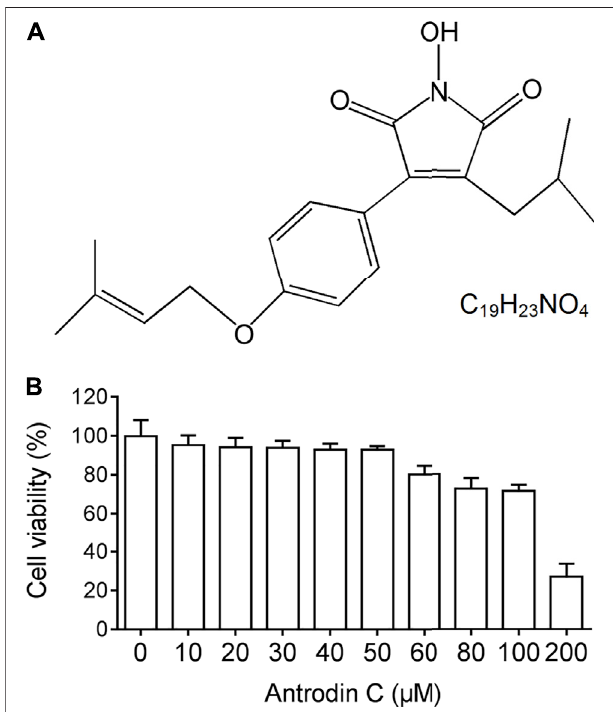
FIGURE 1 | The chemical structure and cell viability of CSFC-8B cells treated with Antrodin C (A) The chemical structure of Antrodin C. (B) Effect of Antrodin C on cell viability of CFSC-8B cells by MTT